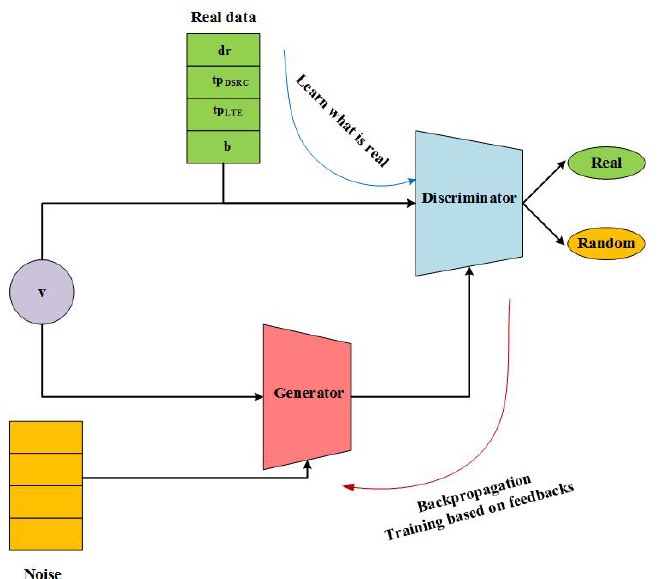
Figure 3. CGAN model for HetVNET.